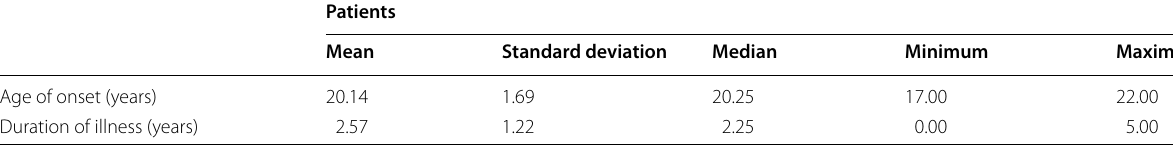
Table 5 Descriptive data regarding age of onset, duration of illness, number of hospitalization and family